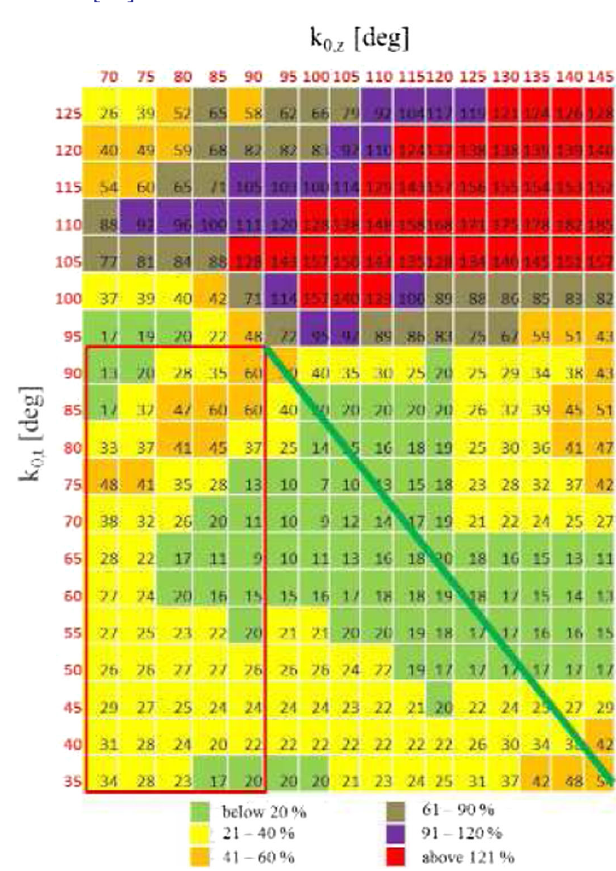
FIG. 4. Relative transverse ( ϵ x þ ϵ y ) rms-emittance growth for zero current phase advances of 35 ° ≤ k 0 ;t ≤ 125 ° and ≤ 145 ° along the first cavity of the DTL for a proton 70 ° ≤ k 0 ;z beam of 2.0 mA. The color code corresponding to the growth rates is